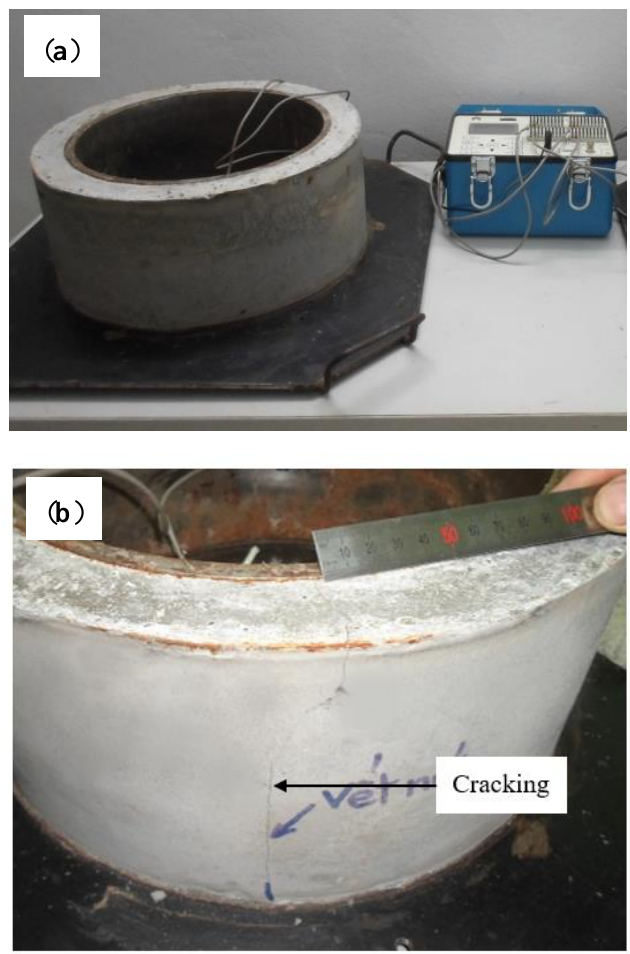
Figure 4. Restrained shrinkage test for HPC samples: ( a ) experimental setup and ( b ) crack formation.